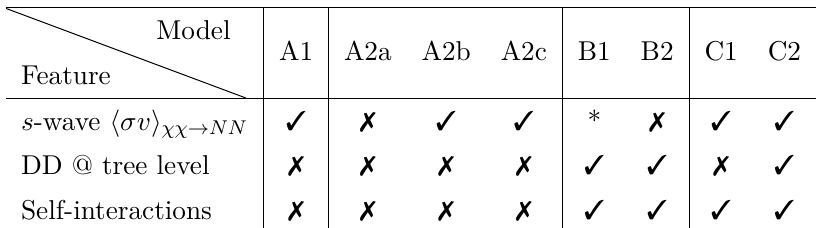
Table 5 . Classification of the phenomenological features of the UV completions discussed in sec- tion 3. Notice that when the DM annihilation cross section h σv i avoid indirect bounds. The asterisk * in Model B1 implies that if the coupling g is real, the ther- mally averaged DM annihilation cross section is p